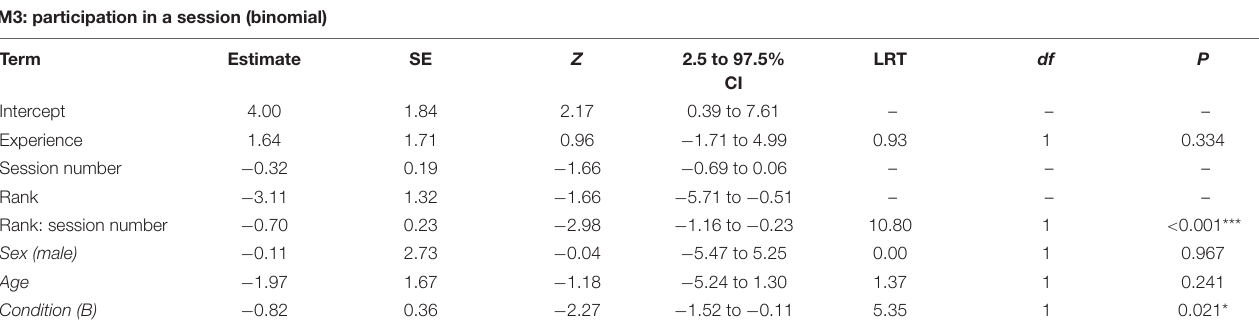
M3: participation in a session